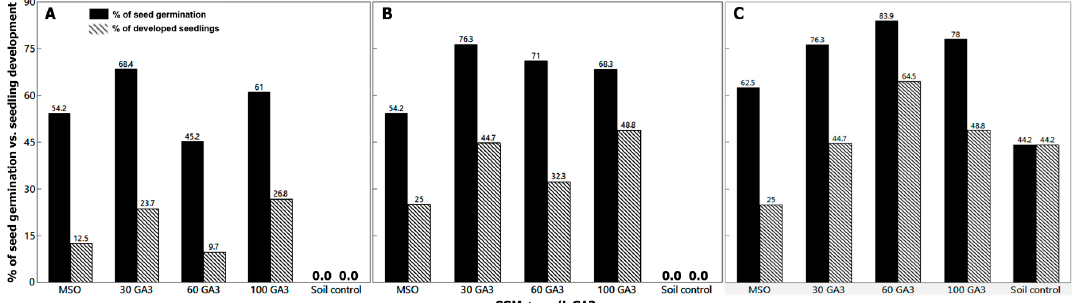
Figure 4. (Exp. I in 2016/2017). Percentage of M. autumnalis seed germination and of fully developed healthy seedlings within ( A ) 14 days; ( B ) 18 days; ( C ) 72 days of the in vitro cultured decoated seeds ( n = 24–41) vs. intact seeds sown in potting soil (soil control), ( n = 43). The survival frequency of the transplanted plantlets ( n = 29) into potting soil was 100% as they reached maturity under the glasshouse conditions (Tables 4 and 5). SGM: Seed germination medium. The intact seeds were stored at 4–5 °C.